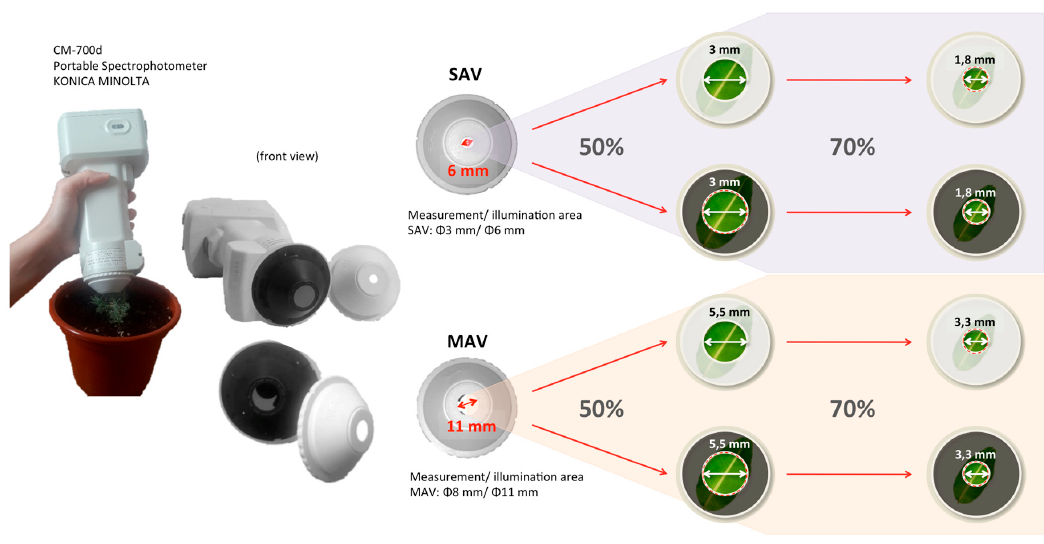
Figure 4. Explanatory diagram of the reduction of the measurement area of the device by means of adaptors in black and white.